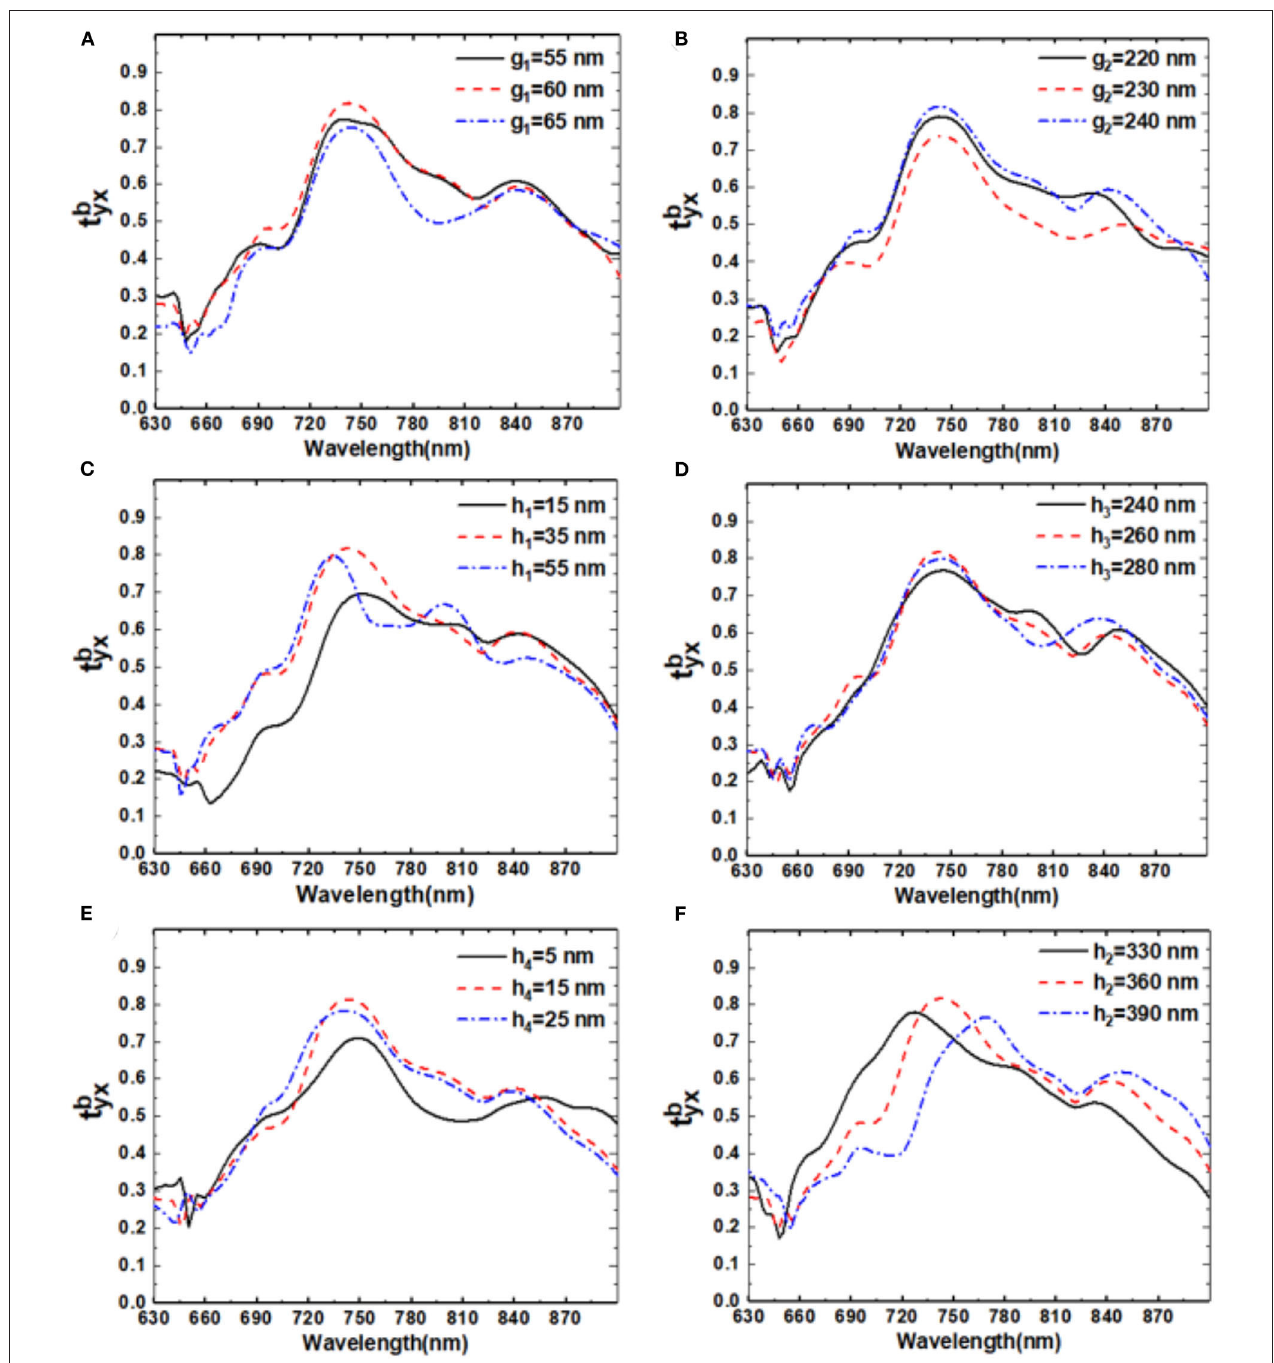
FIGURE 6 | Parameters influence of (A) g 1 , (B) g 2 , (C) h 1 , (D) h 3 , (E) h 4 , and (F) h 2 on the cross-polarized transmission coefficiency of backward propagating x-polarized light.